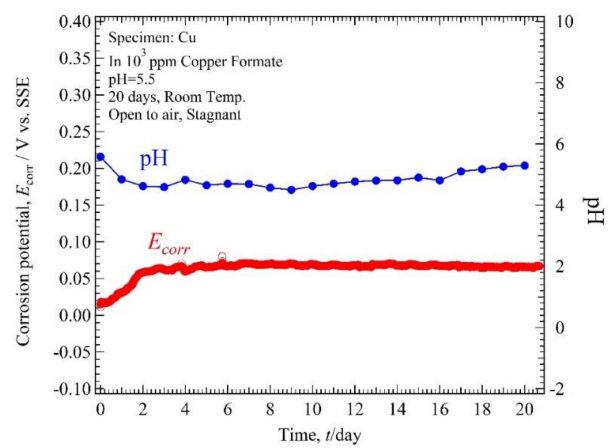
Figure 6. Corrosion potential, solution pH and time plot of Cu tube specimen in 10 3 ppm Cu(HCOO) 2 solution with solution pH 5.5.